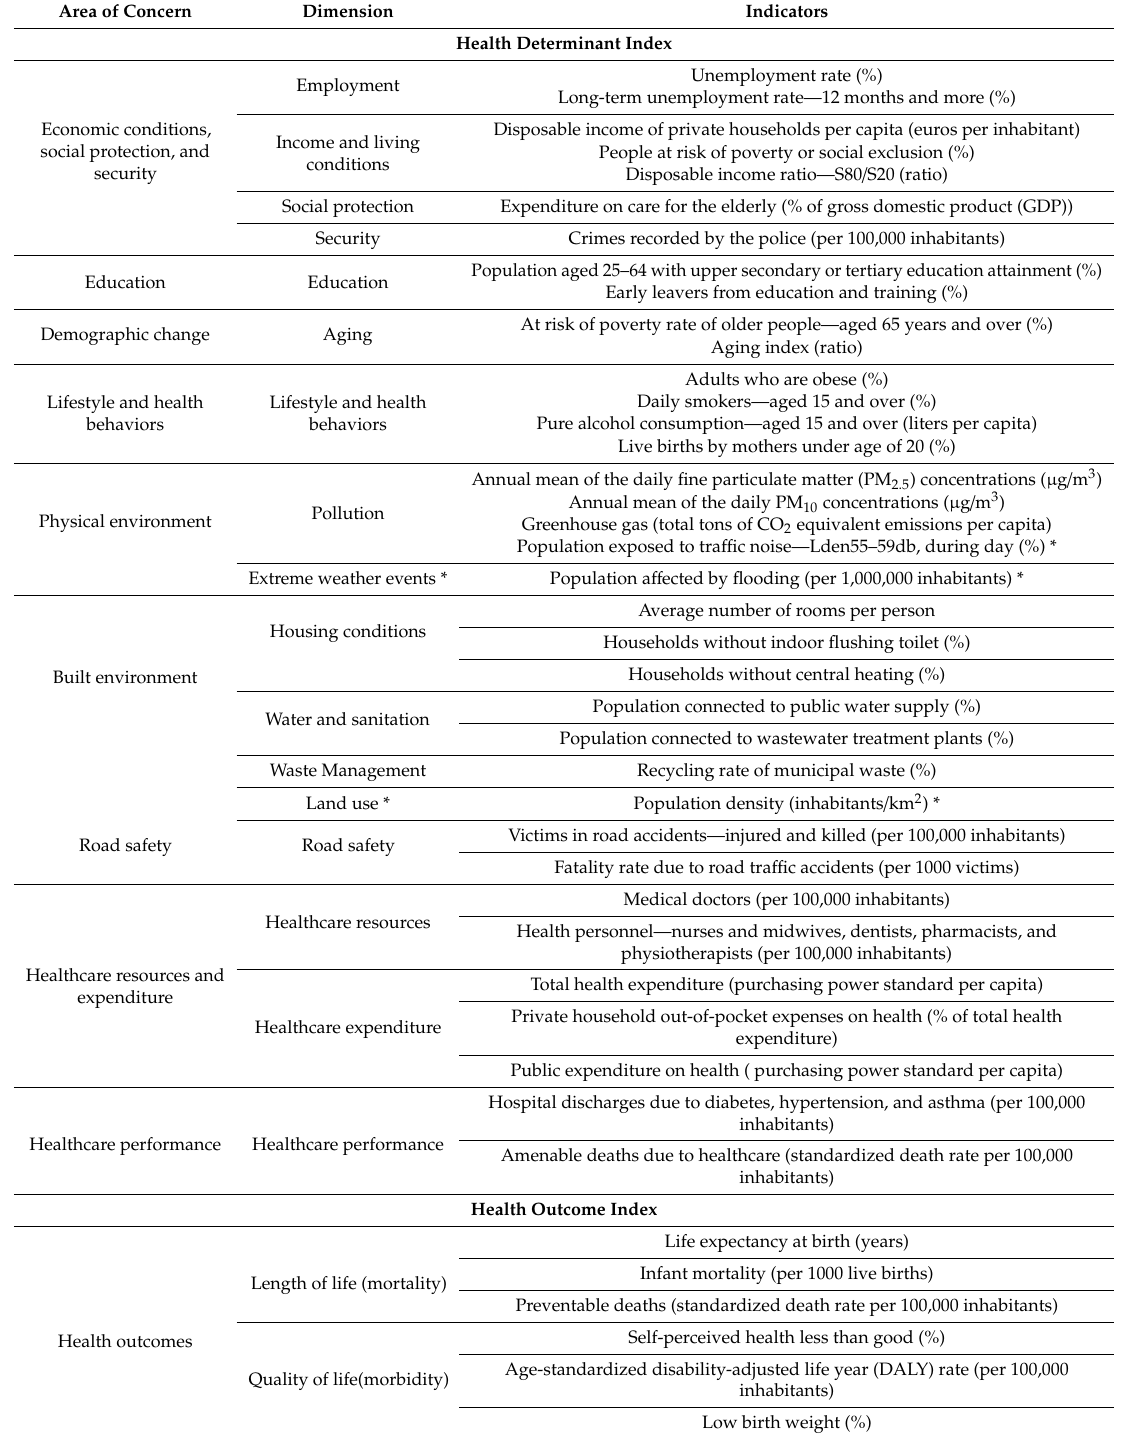
Table 1. Population health index (PHI)